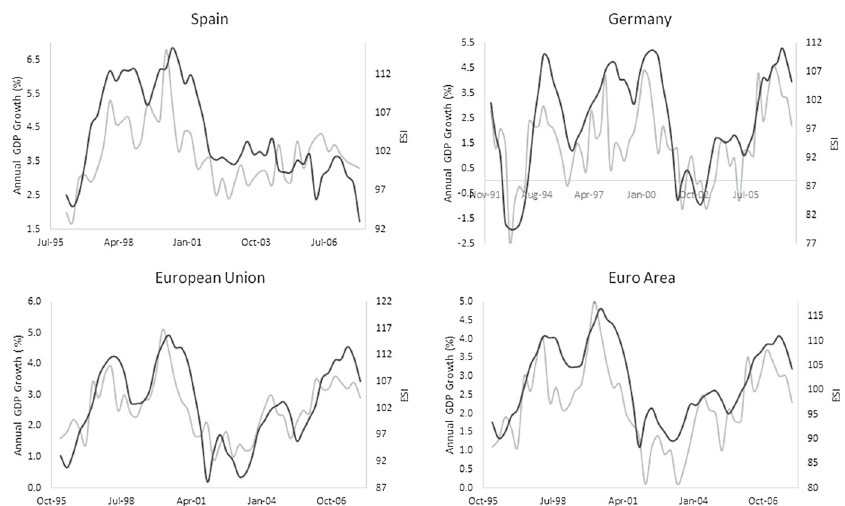
Fig. 2 ESI versus annual GDP growth. Black and gray lines correspond to ESI and GDP, respectively. Source: author’s